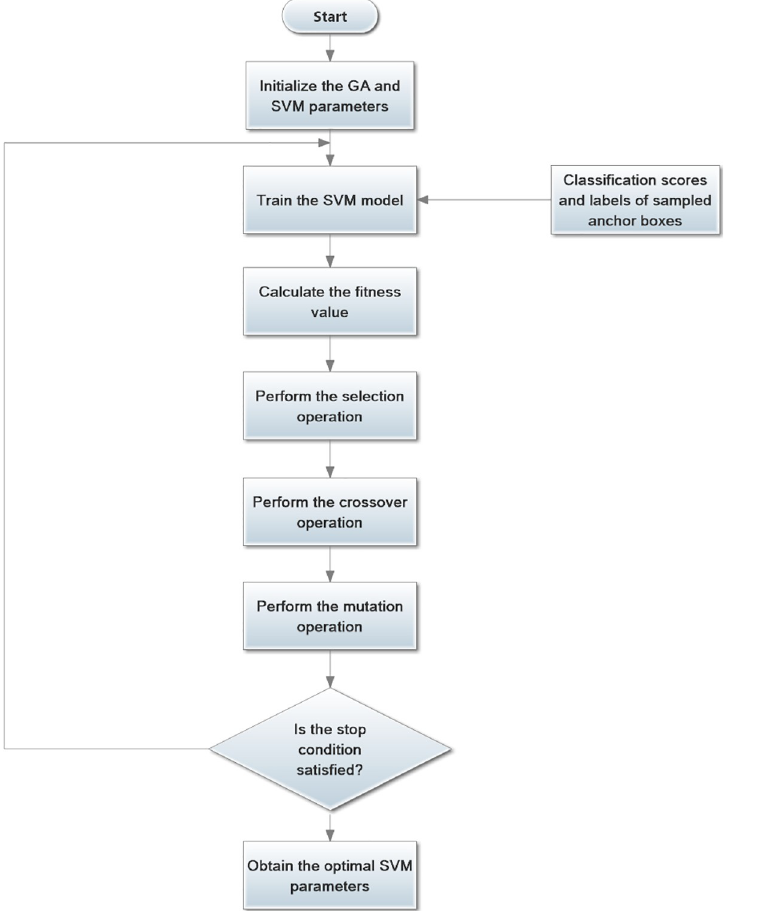
Fig 8. The process of SVM parameter optimization based on the